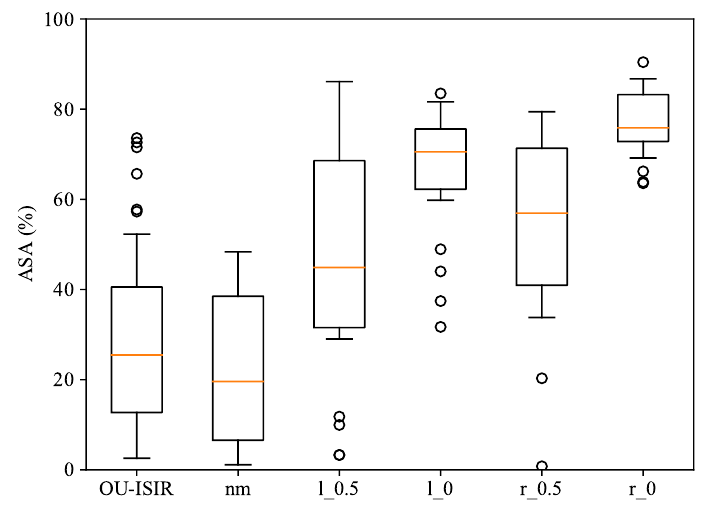
Figure 4. ASA distributions in OU-ISIR and the five styles of INIT.